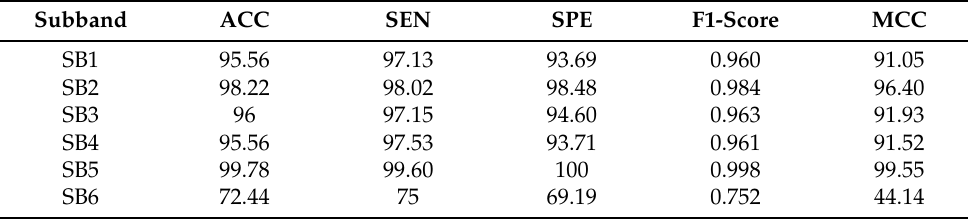
Table 5. Performance Parameter for channel 1 using RBF kernel.